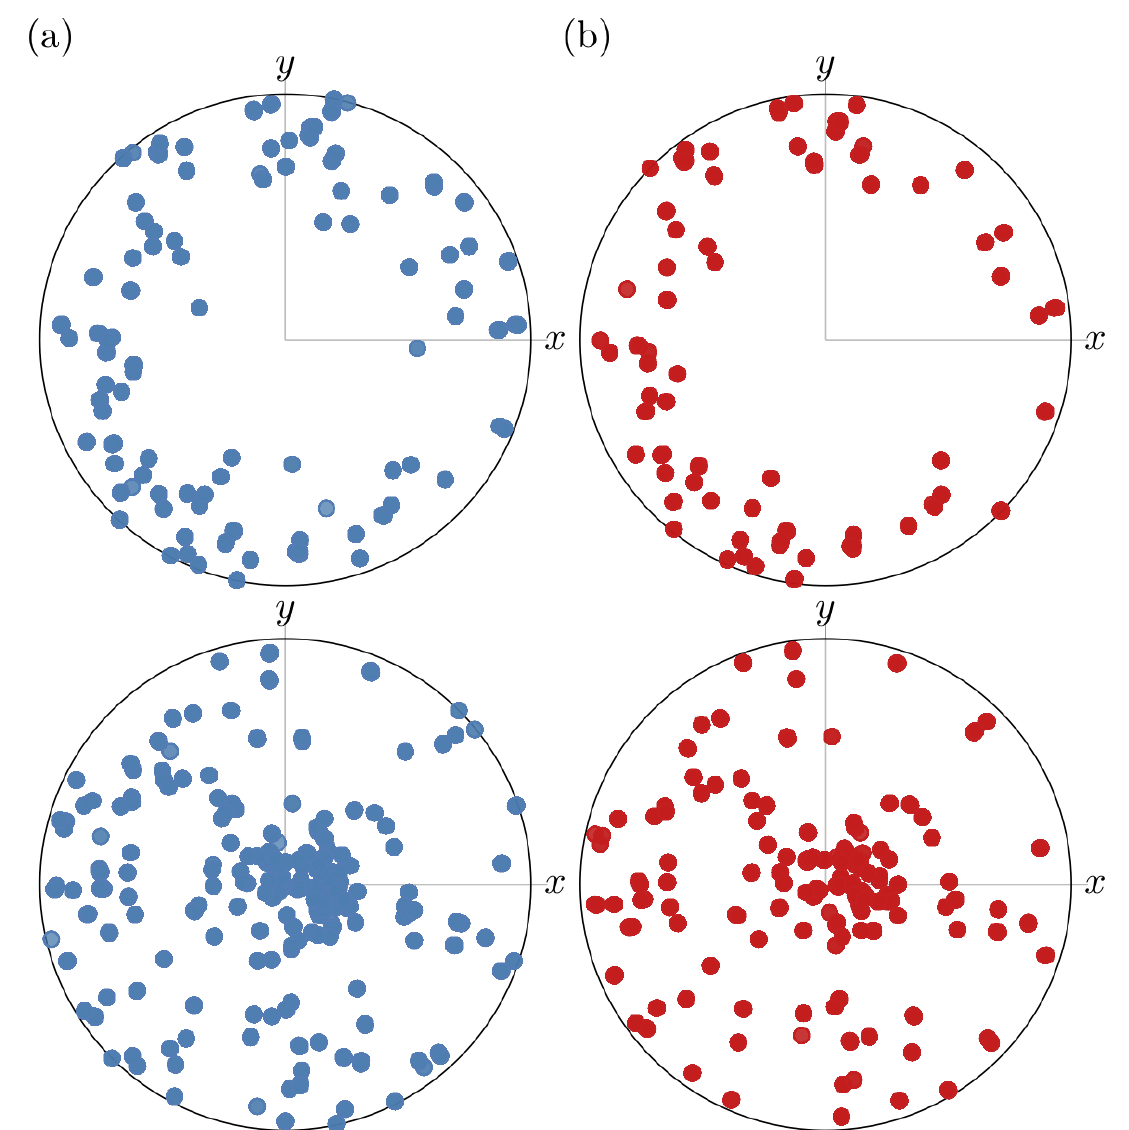
Figure 6. Pole figures showing the direction of the [ 001 ] (top row) and [ 100 ] (bottom row) planes of the Sn crystals. The grains have a [ 100 ] fiber texture where the parallel to the sample surface: ( a ) before heat treatment; and ( b ) after heat